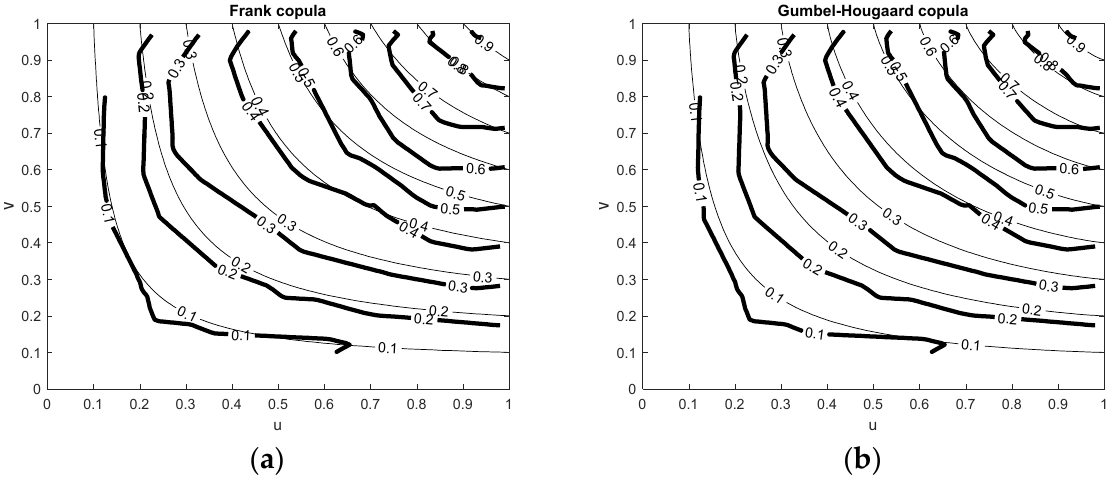
Figure 7. Comparison between the level curves of the theoretical copulas (thin lines) and the empirical copulas (thick lines) for: ( a ) Frank copula; ( b ) Gumbel–Hougaard copula.